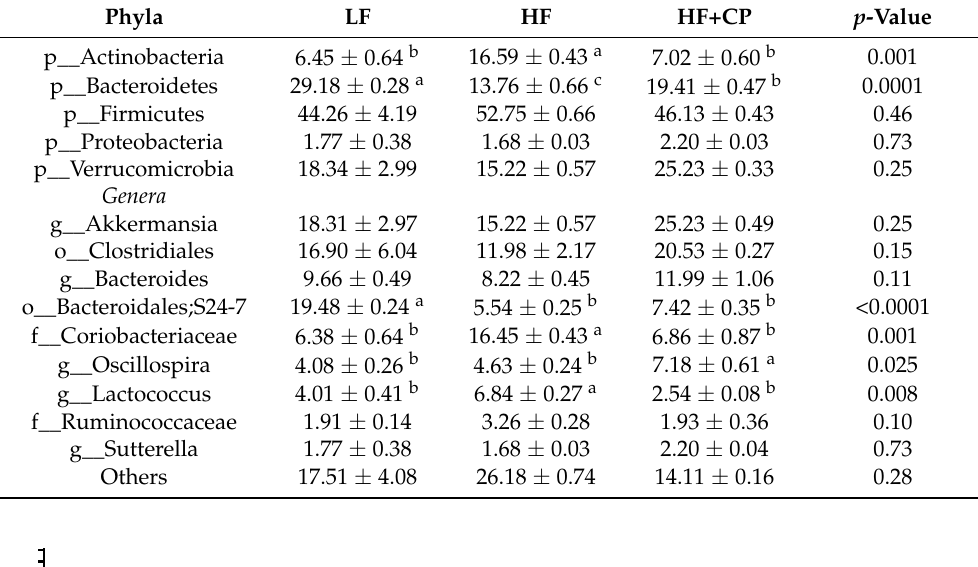
Table 3. Relative abundance of selected bacteria in the cecal microbiome in male C57BL/6J mice fed HF+CP after 10 weeks. a, b Groups not sharing the same lowercase letters indicate that one-way ANOVA found significant differences between groups ( p < 0.05).